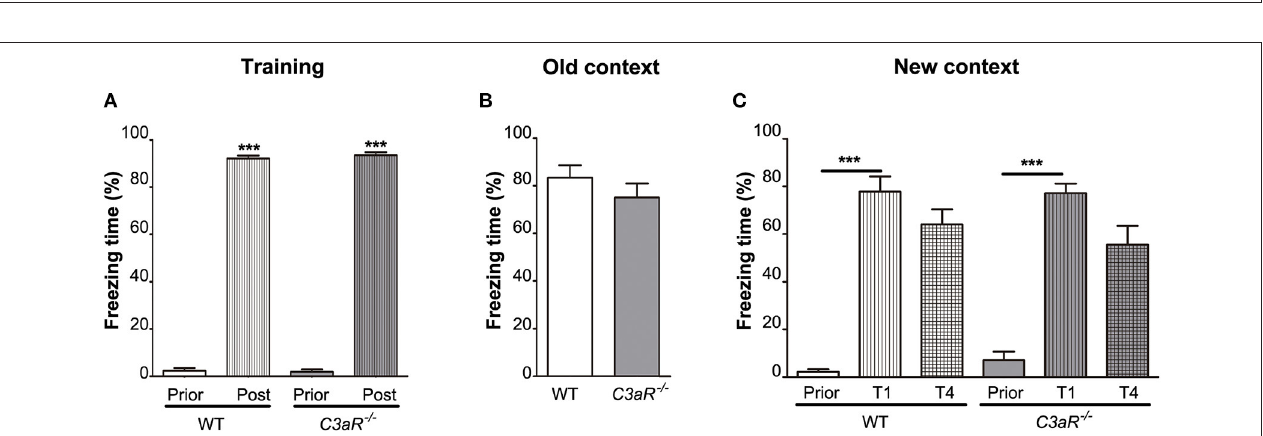
FIGURE 2 | phases. n = 11 (WT) and 8 ( C3aR − / − ). Mean ± SEM. ** p < 0.01 and *** p < 0.001 for within group comparisons; # p < 0.05, ## p < 0.01, and ### p < 0.001 for between group comparisons. Two-tailed unpaired Student’s t -test (A,C,E,G,I,K) and two-way ANOVA followed by a Tukey’s multiple comparisons post-hoc test (B,D,F,H,J,L) .